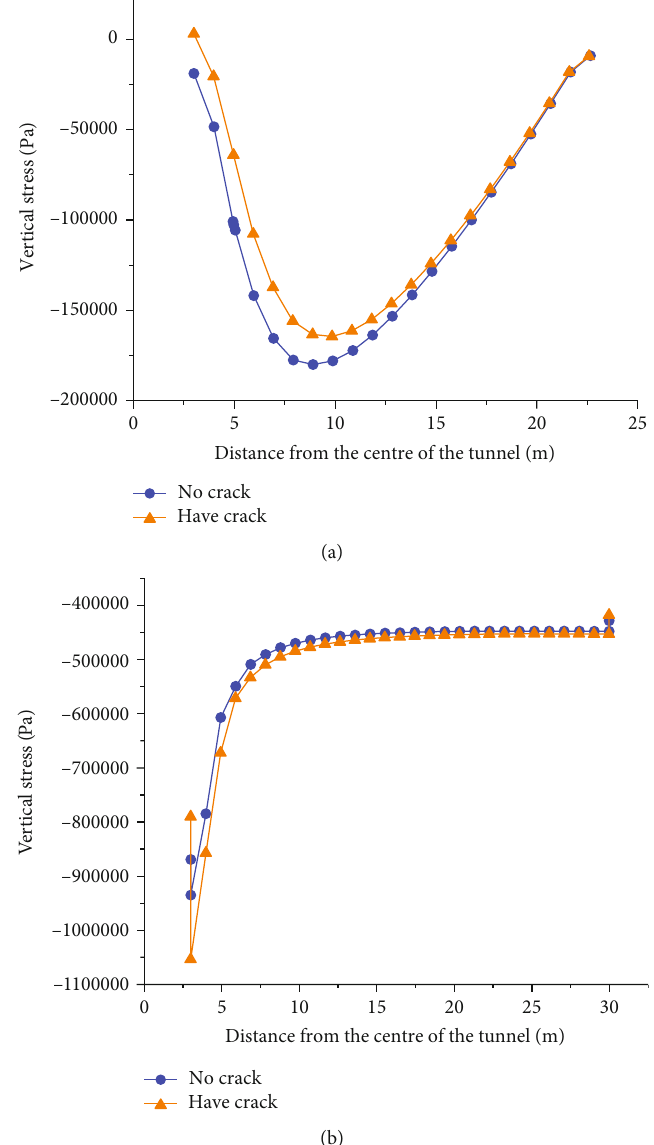
Figure 14: Comparison of vertical stress after excavation. (a) Above the vertical axis of the tunnel. (b) Right of horizontal axis of